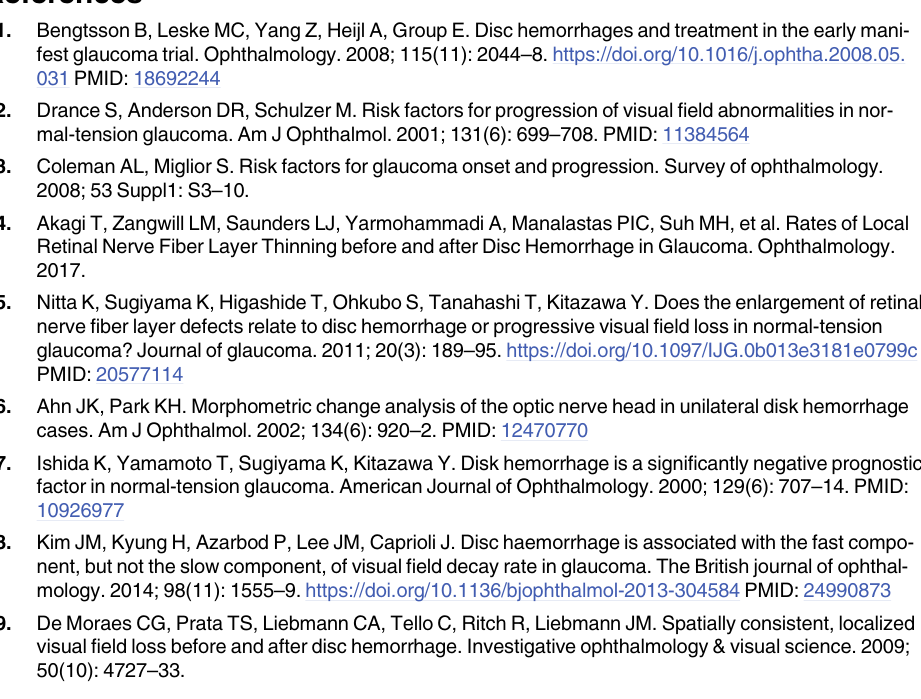
S1 Table. Structural and functional progression data in patients with disc hemorrhage (DH) and those without